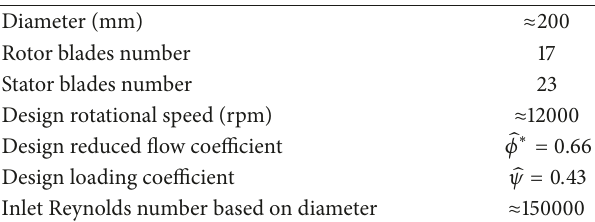
Table 1: Basic properties of the conventional